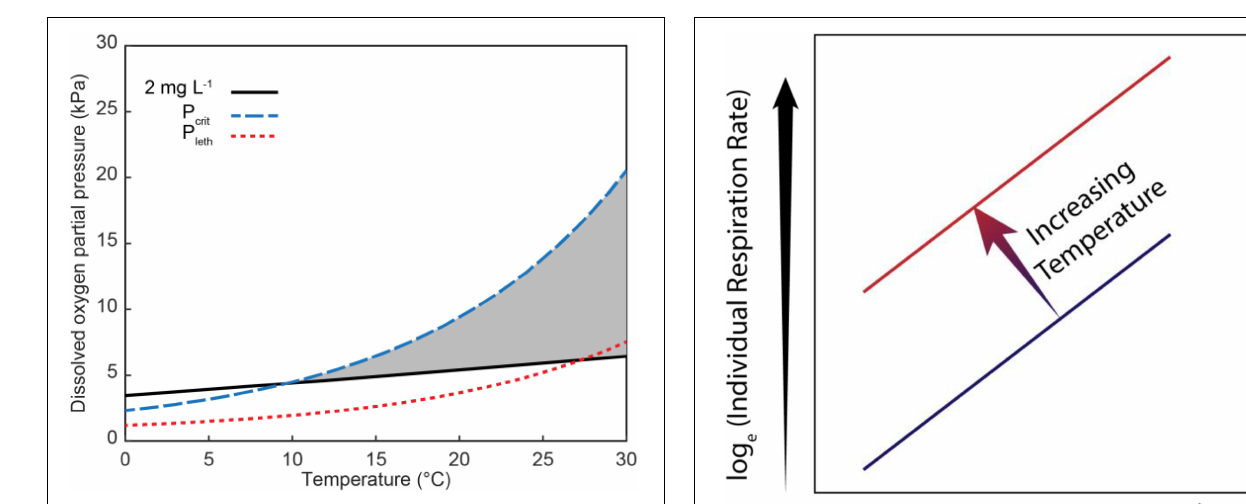
FIGURE 4 | Partial pressure of dissolved oxygen over a range of temperatures for an oxygen concentration of 2 mg L − 1 (solid black line), the P crit (dashed blue line) and P leth (dotted red line) for the copepod A. tonsa (Elliott et al., 2013). Gray area shows region where values for P crit and P leth are greater than the PO 2 at 2 mg L − 1 , and thus where water may not be classified as hypoxic but DO would be below the critical or lethal threshold. The partial pressures of 2 mg L − 1 were calculated as the percent saturation of O2 (Benson and Krause, 1980, 1984) at the given temperature (at assumed salinity of 25), and then multiplying that by 21.198 kPa, the assumed partial pressure of O 2 at the surface.